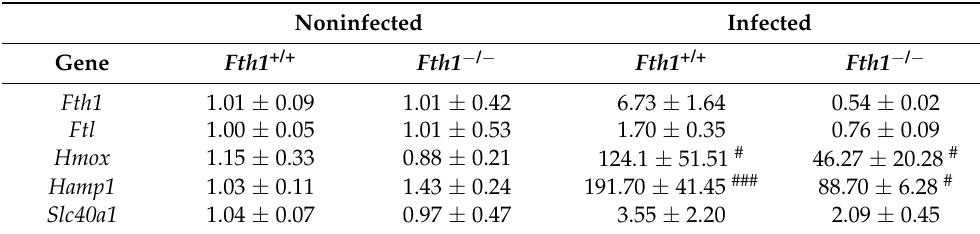
Table 1. Iron-related gene expression induced by mycobacterial